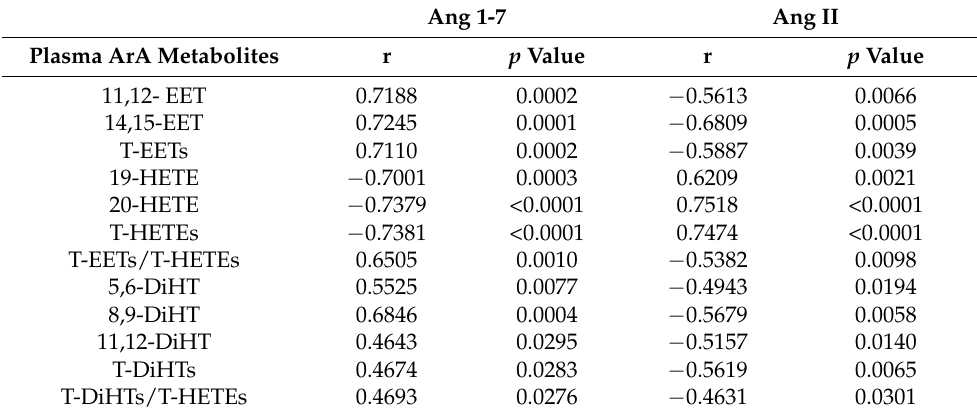
Table 6. Significant linear correlations between RAS peptides and ArA